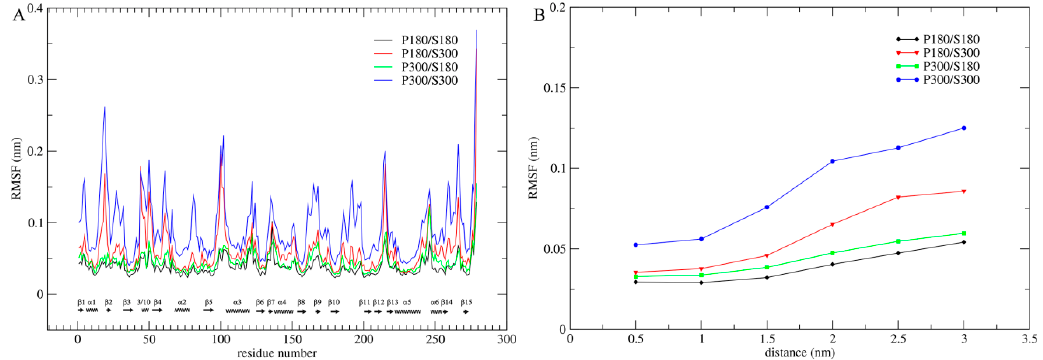
Figure 1. Flexibility profiles of proteinase K calculated from the joined trajectories at the four combined temperatures. ( A ) Per-residue C α RMSF profiles as a function of residue number. SSEs were marked along the horizontal axis with spirals and arrows representing α (or 3/10) helices and β strands, respectively; ( B ) C α RMSF values as a function of distance from the protein core to the protein surface. In both ( A ) and ( B ), the black, red, green, and blue lines are profiles corresponding to the combined temperatures P180/S180, P180/S300, P300/S180, and P300/S300, respectively.